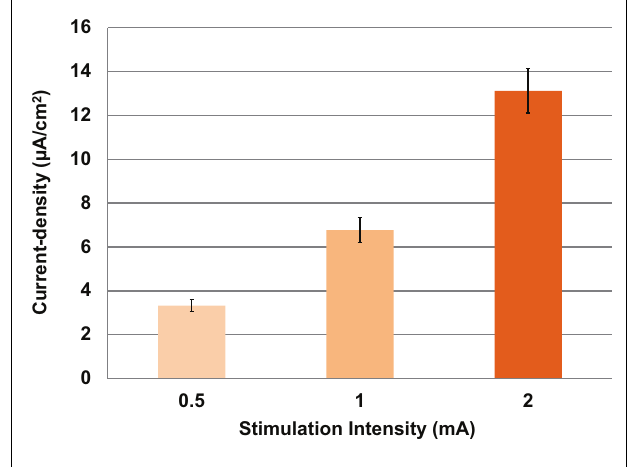
FIGURE 3 |Above is a graph of the increase in mean current densities for all subjects, electrodes and locations at 0.5, 1, and 2mA input currents . Error bars represent ± standard error of the mean.